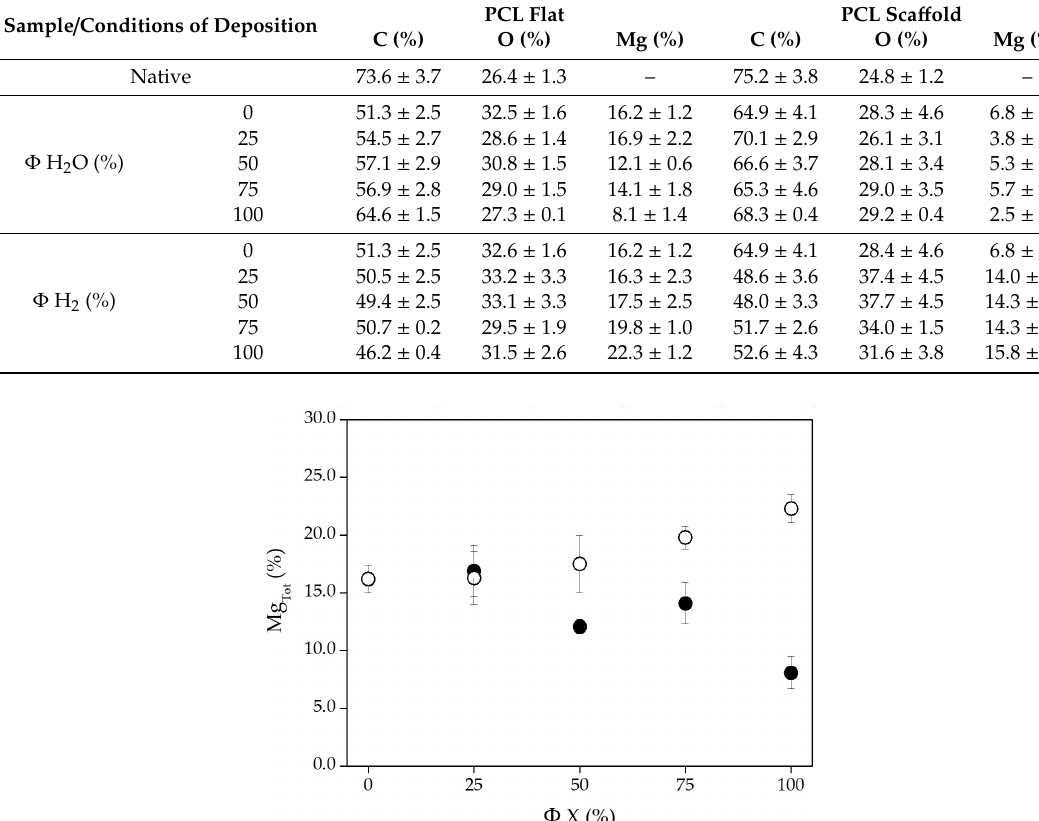
Table 2. Surface atomic composition of native and plasma-processed PCL flat surfaces and scaffolds. Sample/ Conditions